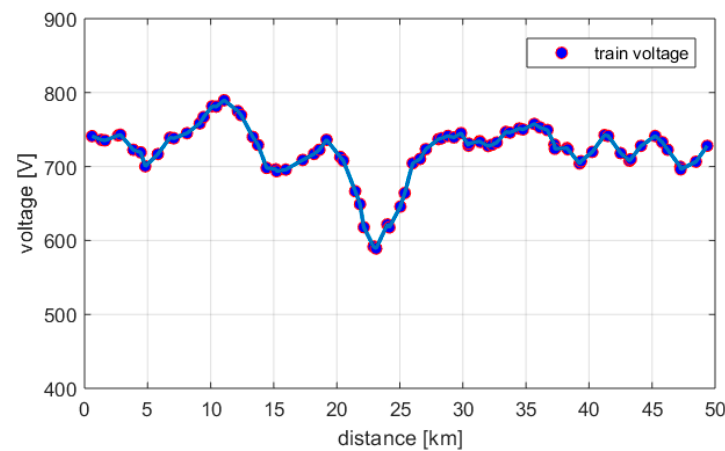
Figure 19. Train voltage against the location.